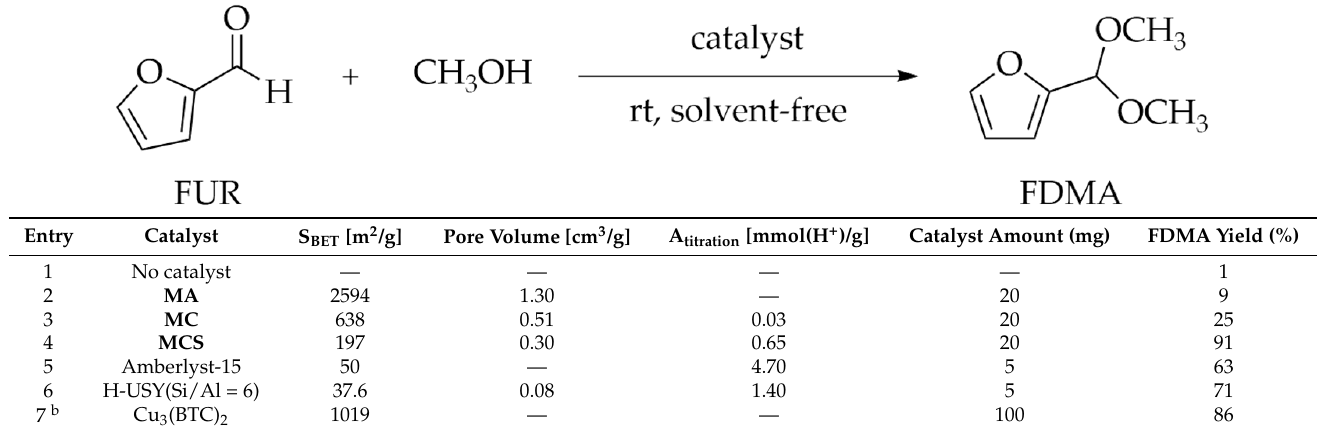
Table 2. Conversion of FUR into FDMA over various catalysts a .